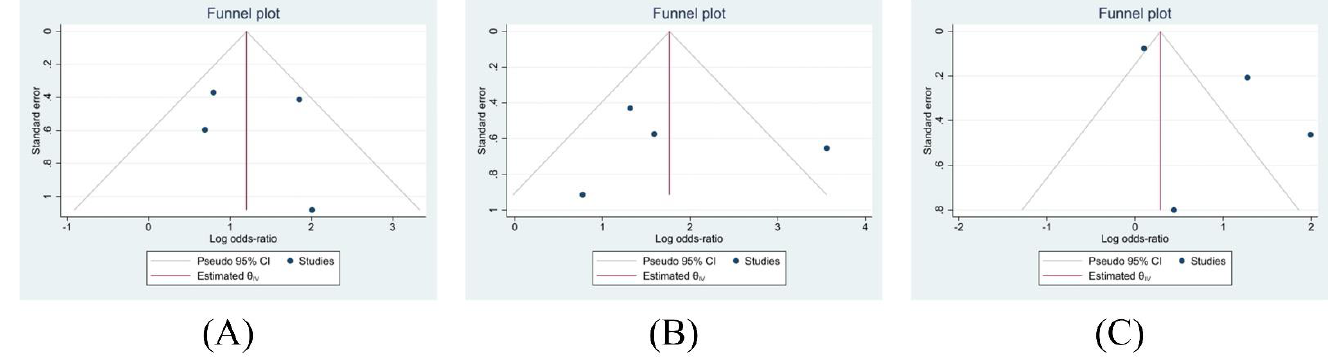
Figure 4. Funnel plot graph: ( A ) passive smoking and LBW, ( B ) incomplete ANC and LBW, and ( C ) incomplete ANC and neonatal